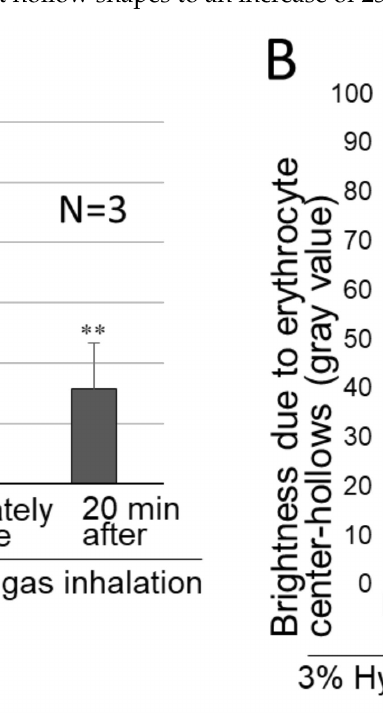
Figure 4. Degrees of erythrocyte-aggregation suppression and biconcave-discoid shape-retention by hydrogen gas inhalation. Before/after inhalation of 3% hydrogen gas for 20 min, whole blood was collected and analyzed for erythrocyte morphology, as in Figure 3. N represents the number of the examined video-extracted still images before/after hydrogen inhalation. ( A ) The erythrocyte- aggregation rates were quantified for numbers of aggregated erythrocytes (Figure 3A,B). ( B ) The opticometry in the cell-central parts containing “central pallor”, was conducted for the biconcave discoid morphology necessary for either erythrocyte cell-flexibility or passing through the capillary vessels, as shown in the cell-brightness-based line-histogram (Figure 3C). The still images and microscopic photographs were analyzed, and shown as mean ± SD, erythrocyte aggregation rate: n = 3; average of gray values: n = 15, immediately before inhalation and n = 7 for 20 min after the inhalation ended. ** p < 0.01 (versus immediately before 3% hydrogen gas